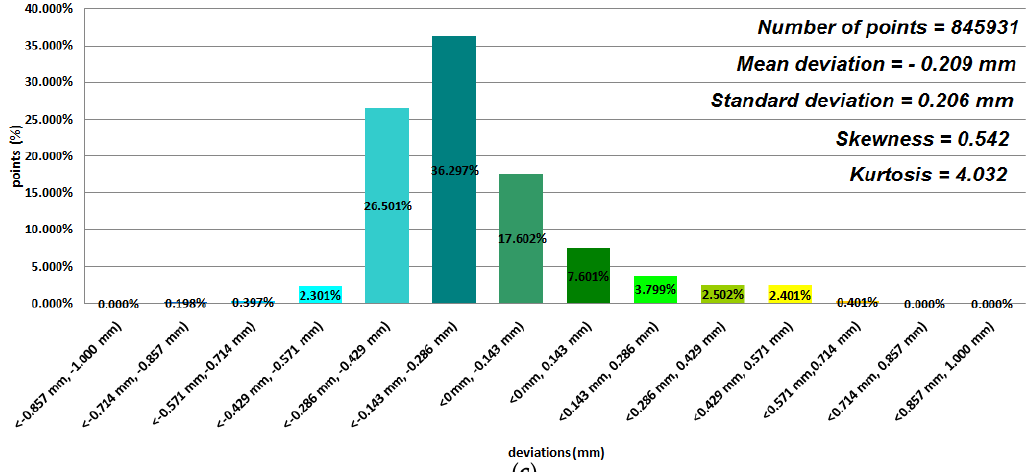
Figure 5. Histograms representing average results of the 12 mandible structures: ( a ) Polyethylene terephthalate (PET) material; ( b ) E-Partial material; ( c ) E-Denstone material.